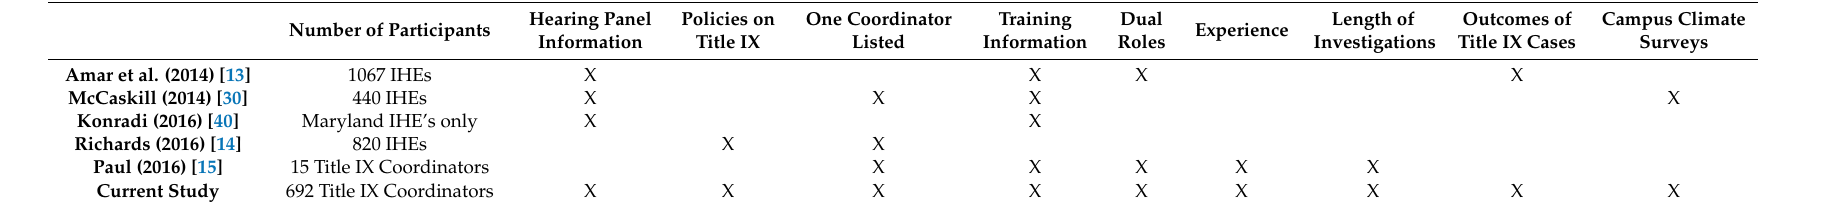
Table 2. A review of the literature on Title IX coordinators since the 2011 Dear Colleague